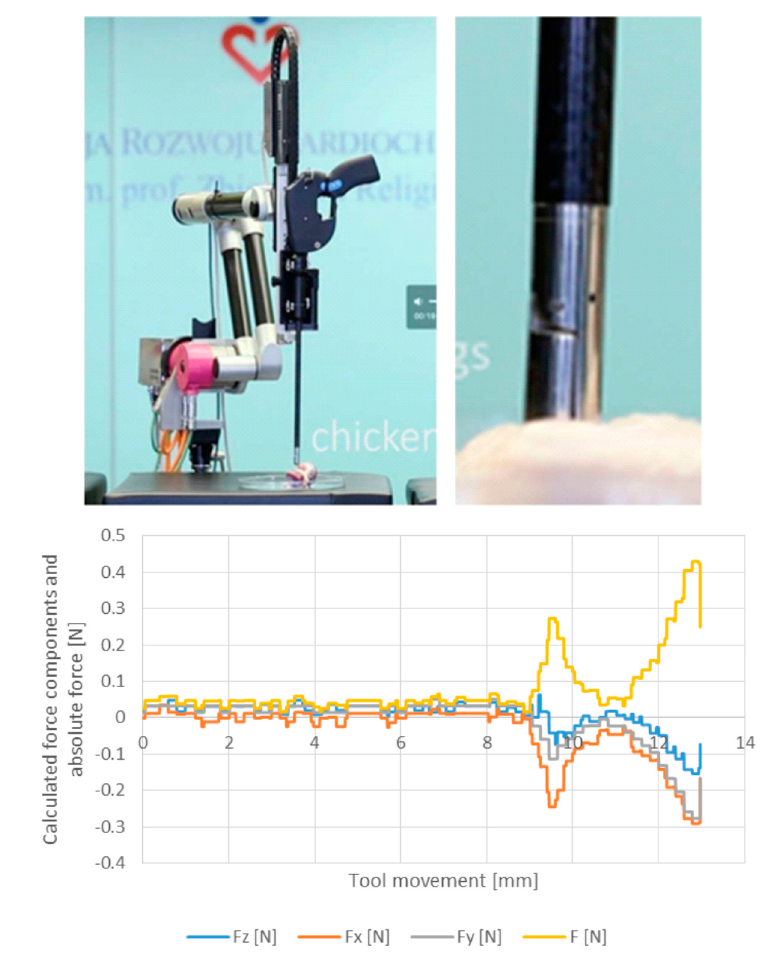
Figure 2. Testing tissue hardness: the laparoscope moved perpendicularly with constant speed in a chicken wing. Measured forces (N) versus distance (mm) as the laparoscope approaches and touches chicken bone and muscular tissue. Touching contact point is at 9